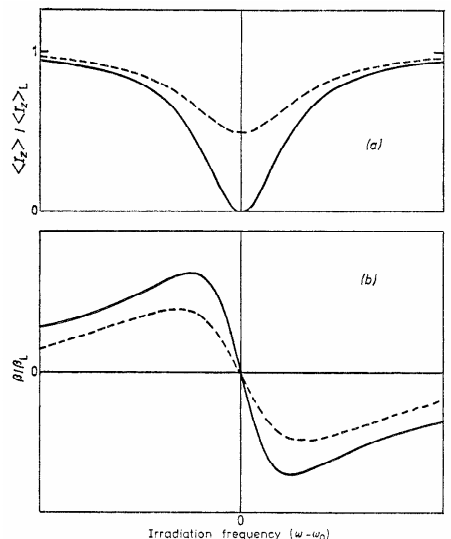
Figure 3. Variation of polarization ( a ) and of dipolar inverse temperature ( b ) as a function of irradiation frequency for a spin system in high field according to spin-temperature theory. Full curves: complete saturation, broken curves—partial saturation. (From Reference [9] © (1978) IOP Publishing. Reproduced with permission. All rights reserved).